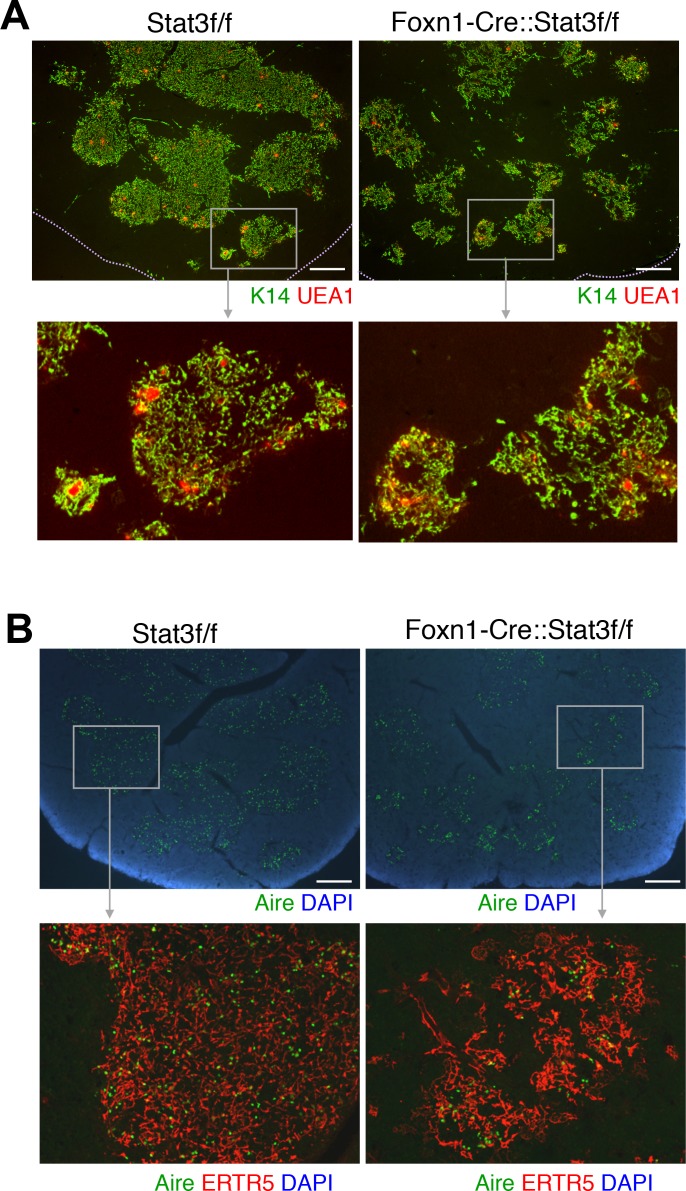
Maturation of mTECs was not affected in Foxn1-Stat3-CKO.Cryostat sections of the thymus were stained with antibodies directed to K14 (green) and UEA1 (red) (A), and with antibodies to ERTR5 (red) and AIRE (green) (B). Sections were counterstained with DAPI (blue). Scale bars: 400 μm.